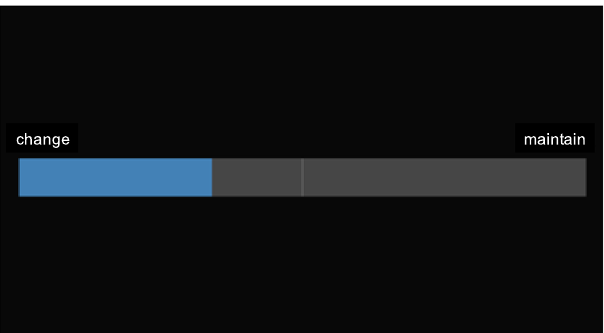
Figure 1. Screenshot of the tactile digital slider used by the musicians to annotate their performance while listening back to it. 16 musicians were asked to rate the extent to which they were trying to change, or on the contrary to support, the music produced by the group.